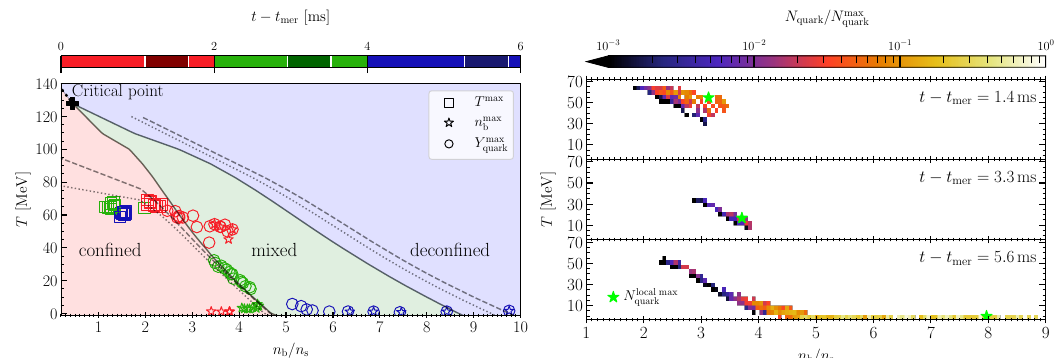
Figure 4: Left: Phase diagram of the Soft_q07 post-merger evolution, with regions of confined, mixed and deconfined phases of matter shown. Here squares correspond to the maximum temperature, circles to the maximum quark fraction, and stars to the maximum density at a given time in the evolution. Furthermore, points with a specific colour all occur within the time intervals indicated by darker colour bars. Right: The amount of quarks in the orbital plane, measured using the same times as in Fig. 3. We normalize the measured amount of quarks by the maximal amount found in all three time slices presented